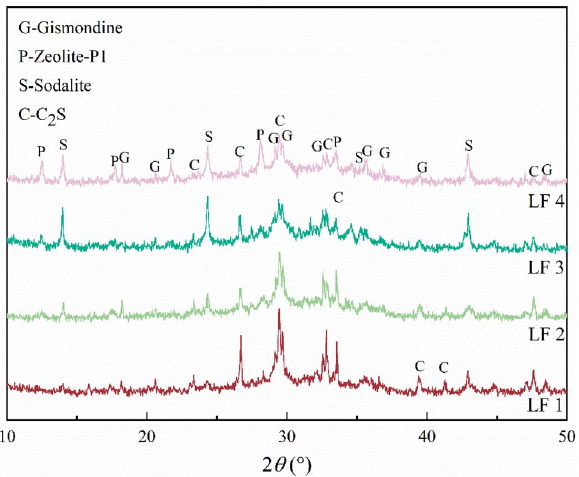
Figure 2. XRD patterns of hydrothermal products with different mass ratio of LFS to FA; LF 1:the mass ratio of LFS to FA is 4:6, LF 2: the mass ratio of LFS to FA is 5:5, LF 3: the mass ratio of LFS to FA is 6:4, LF 4: the mass ratio of LFS to FA is 7:3.